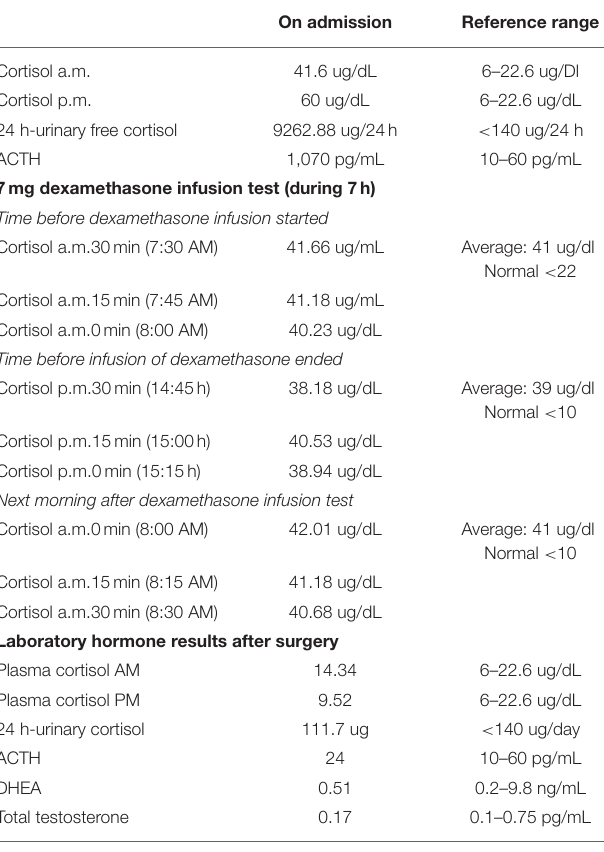
infusion of 7mg dexamethasone suppression test. On